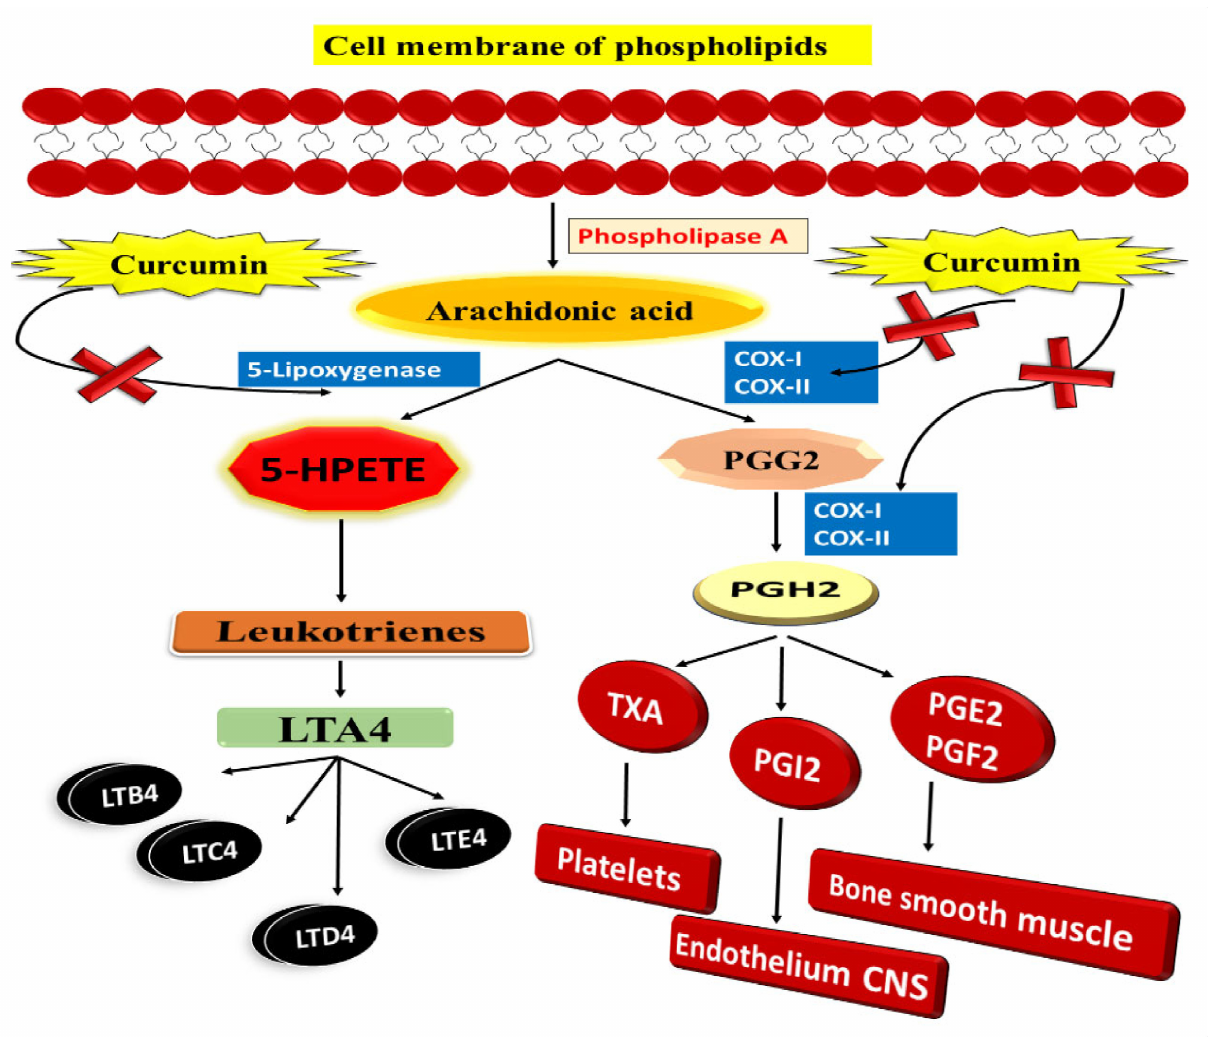
Figure 7. Curcumin and the arachidonic acid metabolism: A potential inhibitory